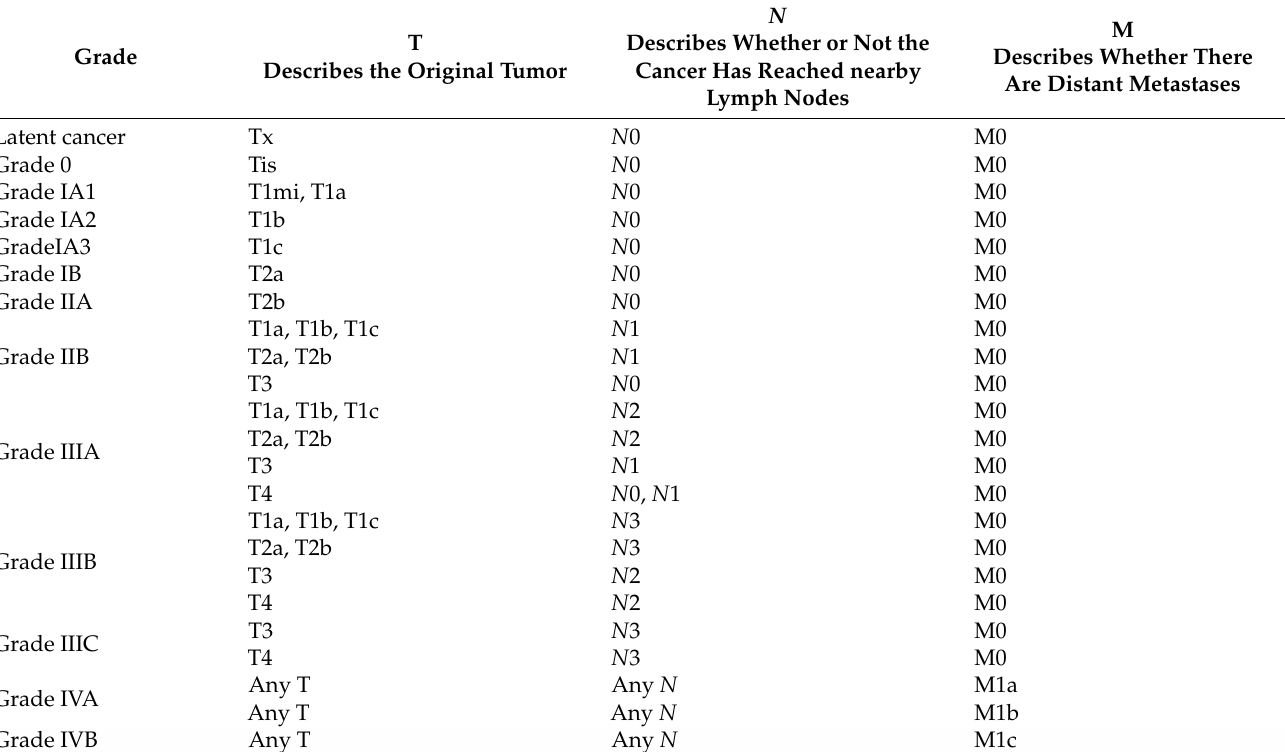
Table 3. Clinical advancement of lung neuroendocrine neoplasms based on the TNM scale according to the AJCC (American Joint Committee on Cancer) based on